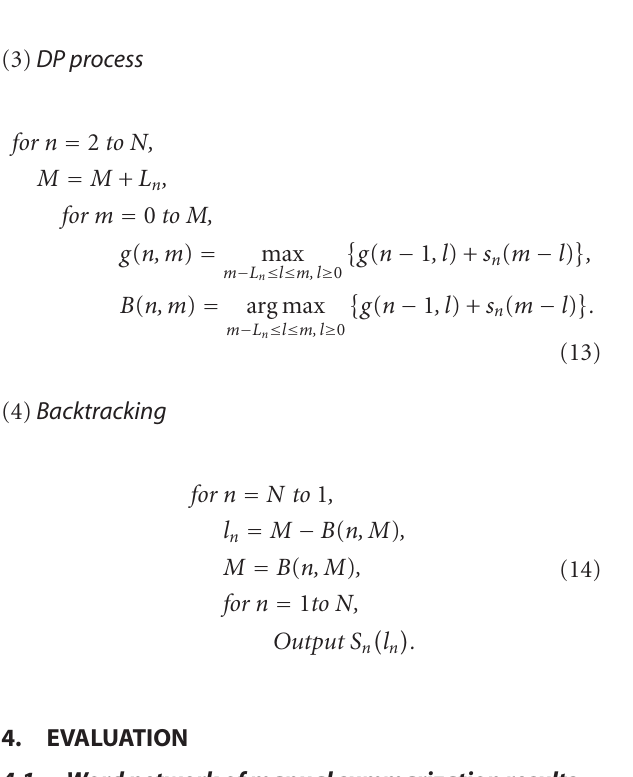
Figure 8: Example to calculate summarization accuracy using a word network. The underlined word and (cid:18) DEL (cid:19) in automatic summarization represent a substitution error and a deletion error. The summarization accuracy is given by